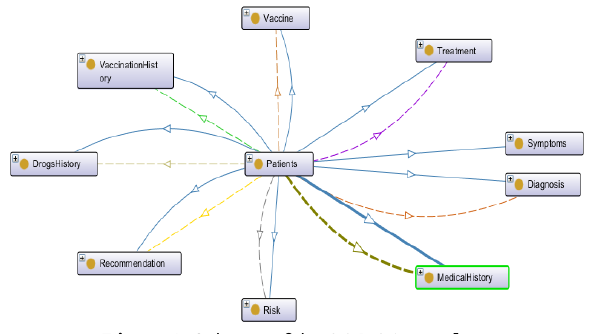
Figure 1. Schema of the CODCA ontology.